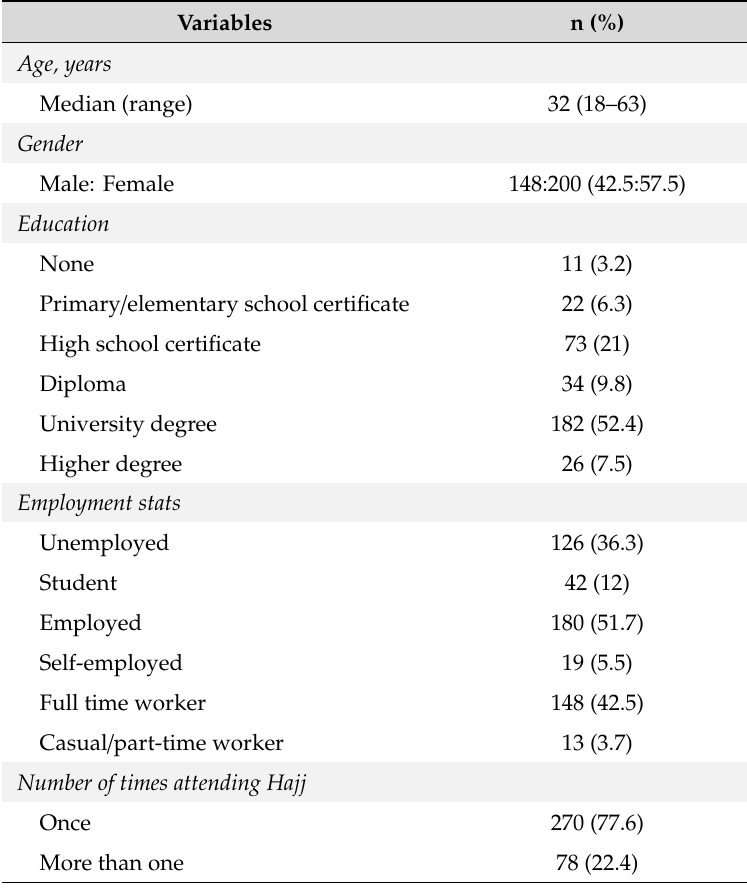
Table 1. Demographic characteristics of respondents (N =